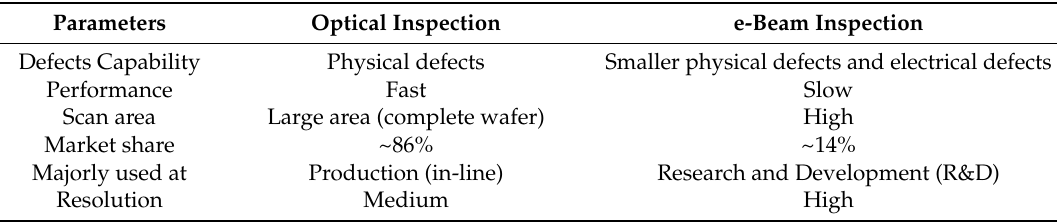
Table 1. E-Beam versus optical